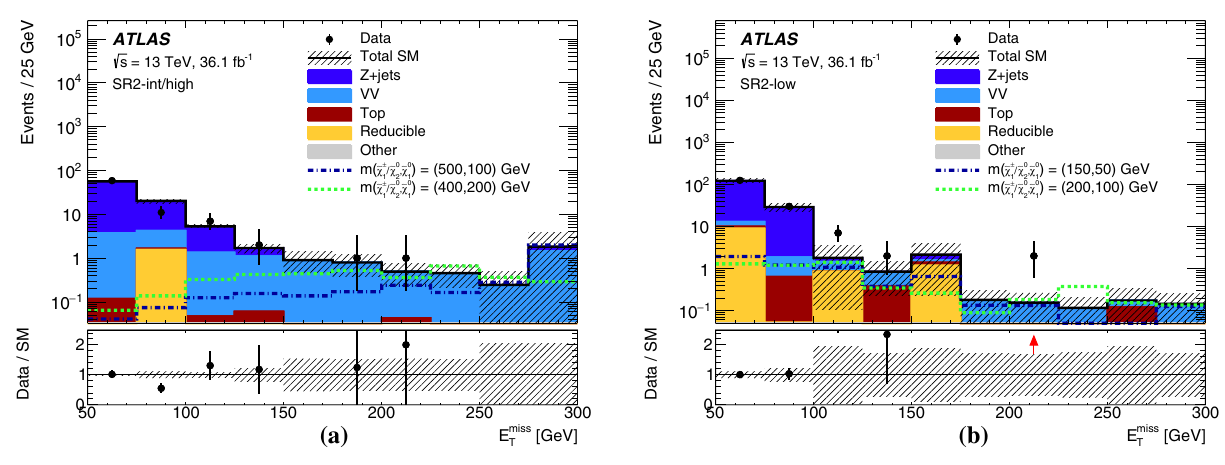
Fig. 5 Distributions of E miss for data and the expected SM back- T groundsinthe2 (cid:4) +jetschannelfor a SR2-int/highand b SR2-low,with- out the final E miss